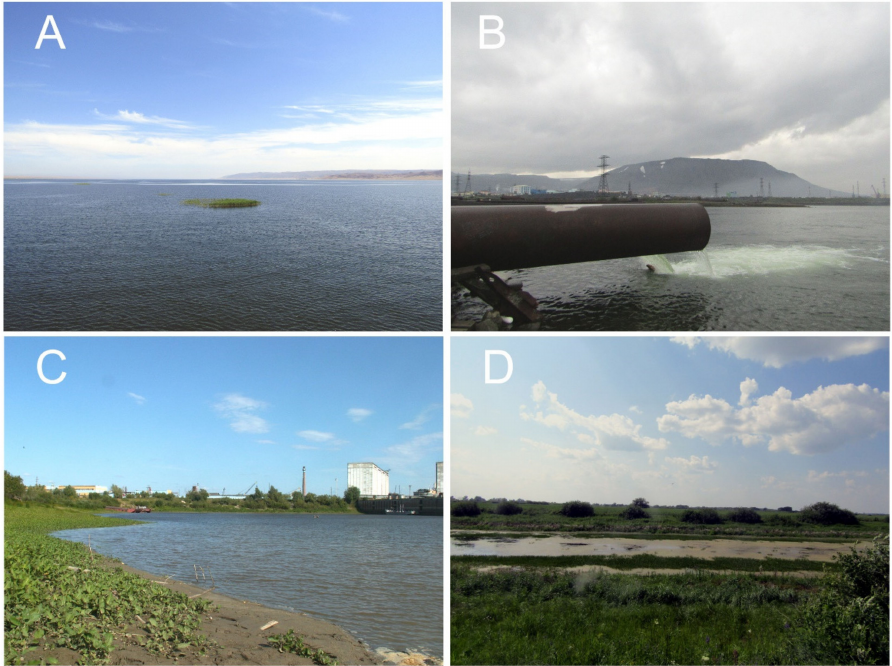
Figure 2. Some habitats of neobiotic freshwater species of Mollusca in Siberia. ( A ) The